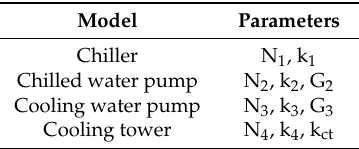
Table 4. Mathematical model parameters.